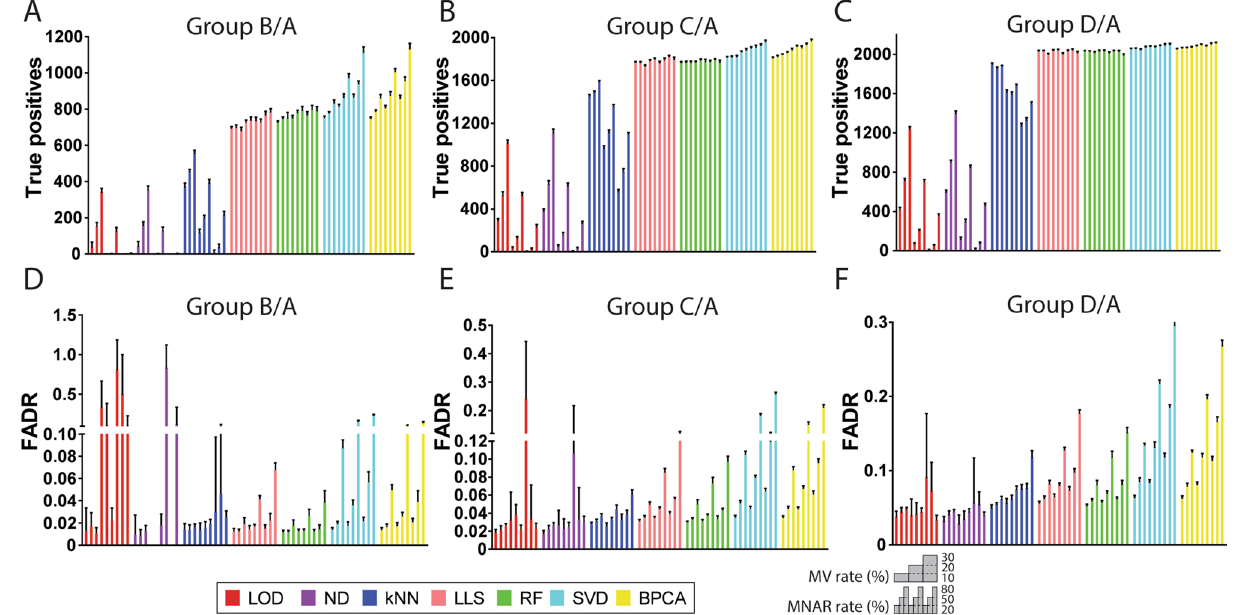
Figure 3. True positive detection and false altered-protein discovery rate with the benchmark dataset. Between Group B-D and Group A, true positives (TPs) are E.coli and yeast proteins with adjusted p-value < 0.05, and false positives (FPs) are human proteins with adjusted p-value < 0.05. False altered-protein discovery rate (FADR) is defined as the proportion of FPs in all positives. ( A – C ) Amounts of TPs detected in nine MV-MNAR conditions for each imputation method. ( D – F ) FADR in nine MV-MNAR conditions for each imputation method. In each graph, bars represent average values of ten repeats in each MV-MNAR condition, and error bars represent standard deviations. Nine MV-MNAR conditions are (from left to right): 10%MV-20%MNAR, 10%MV-50%MNAR, 10%MV-80%MNAR, 20%MV-20%MNAR, 20%MV-50%MNAR,